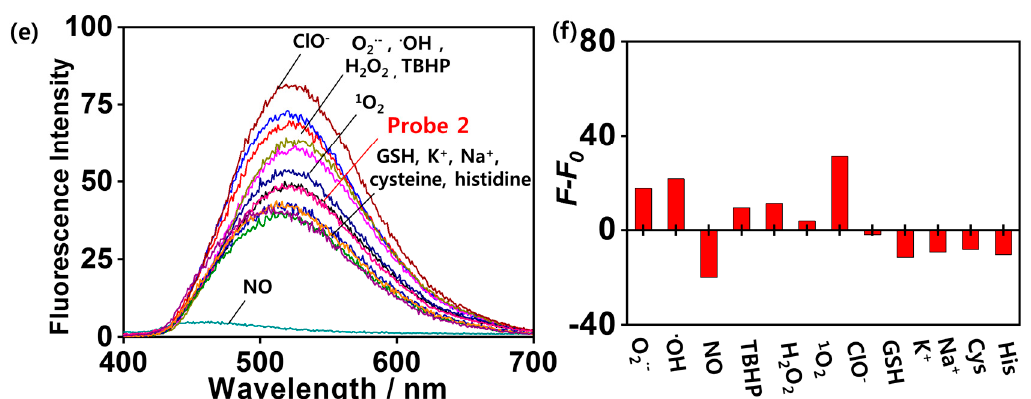
Figure 3. Photographs of ( a ) 1 (25 µ M) and ( b ) 2 (6.25 µ M) with ROS (10 equiv.), metal ions (10 equiv.), or amino acids (10 equiv.) in DMSO/H 2 O (1/99, v / v %) under UV lamp. Fluorescence spectra (Excitation wavelength: 360 nm for probe 1 and 371 nm for probe 2 ) of ( c ) 1 and ( e ) 2 with ROS (10 equiv.), metal ions (10 equiv.), or amino acids (10 equiv.) in DMSO/H 2 O (1/99, v / v %). Fluorescence intensity of probes ( d ) 1 and ( f ) 2 in the presence of ROS, metal ions, and amino acids in DMSO/H 2 O (1/99, v / v %).